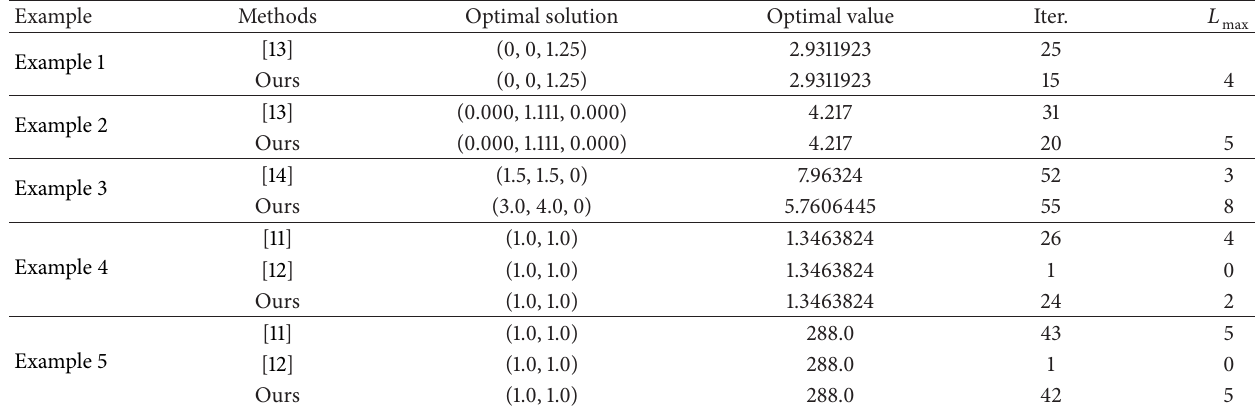
Table 1: Computational results of Examples